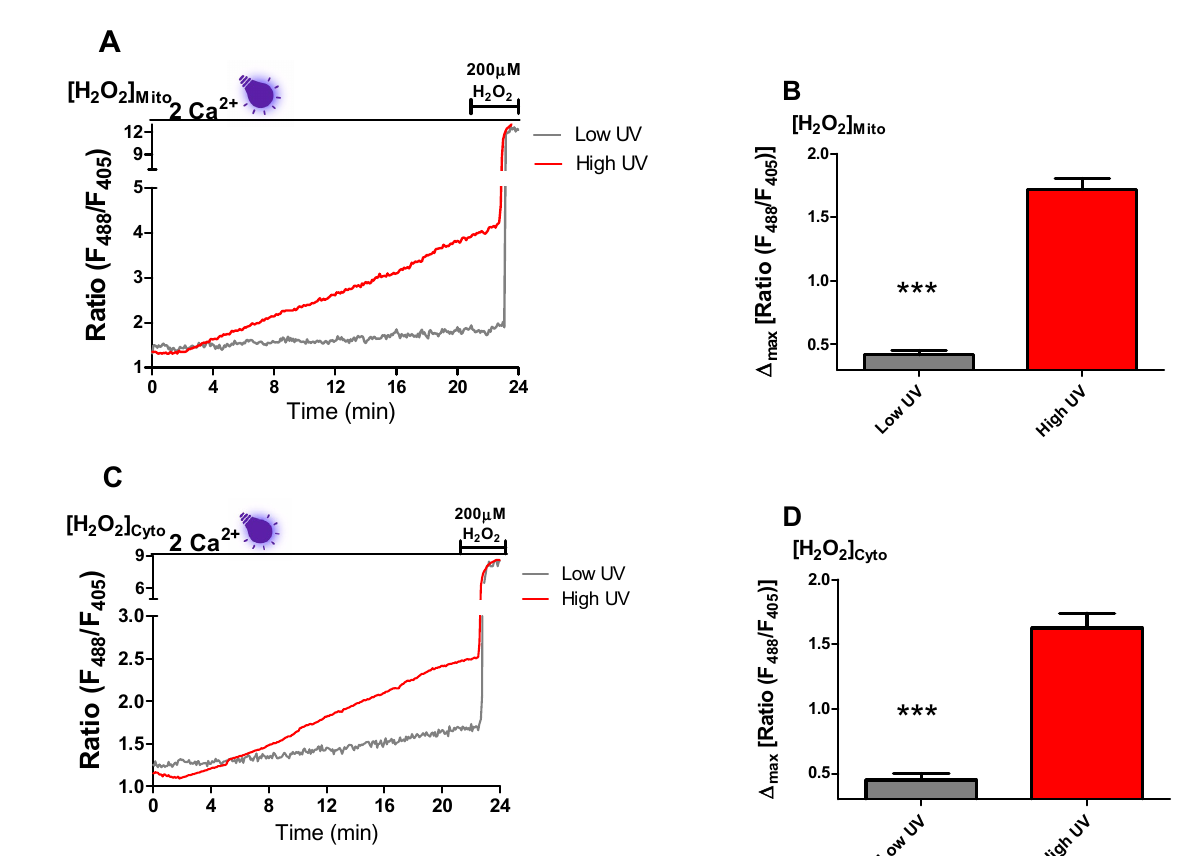
Figure 3. High near-UV light induces mitochondrial and cytosolic ROS production. Representative traces show the production of H 2 O 2 in mitochondria ( A ) and cytosol ( C ) following the excitation of cells with 5 mW (low-UV) and 20 mW of a 405 nm laser line (high-UV). Right panels represent MEAN + SEM of H 2 O 2 levels in mitochondria ( B ) and cytosol ( D ) after 20 min exposure to low-UV (gray) and high-UV (red). Significant differences were assessed via unpaired t -test and presented as specific p -values (*** p < 0.001). Low UV ( n = 24) high UV ( n = 43) in mitochondria and low UV ( n = 20) high UV ( n = 30) in cytosol.